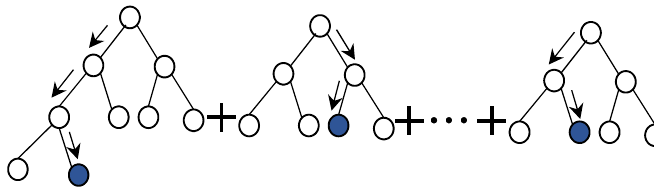
Figure A5. The architecture of Boosted Regression Tree.